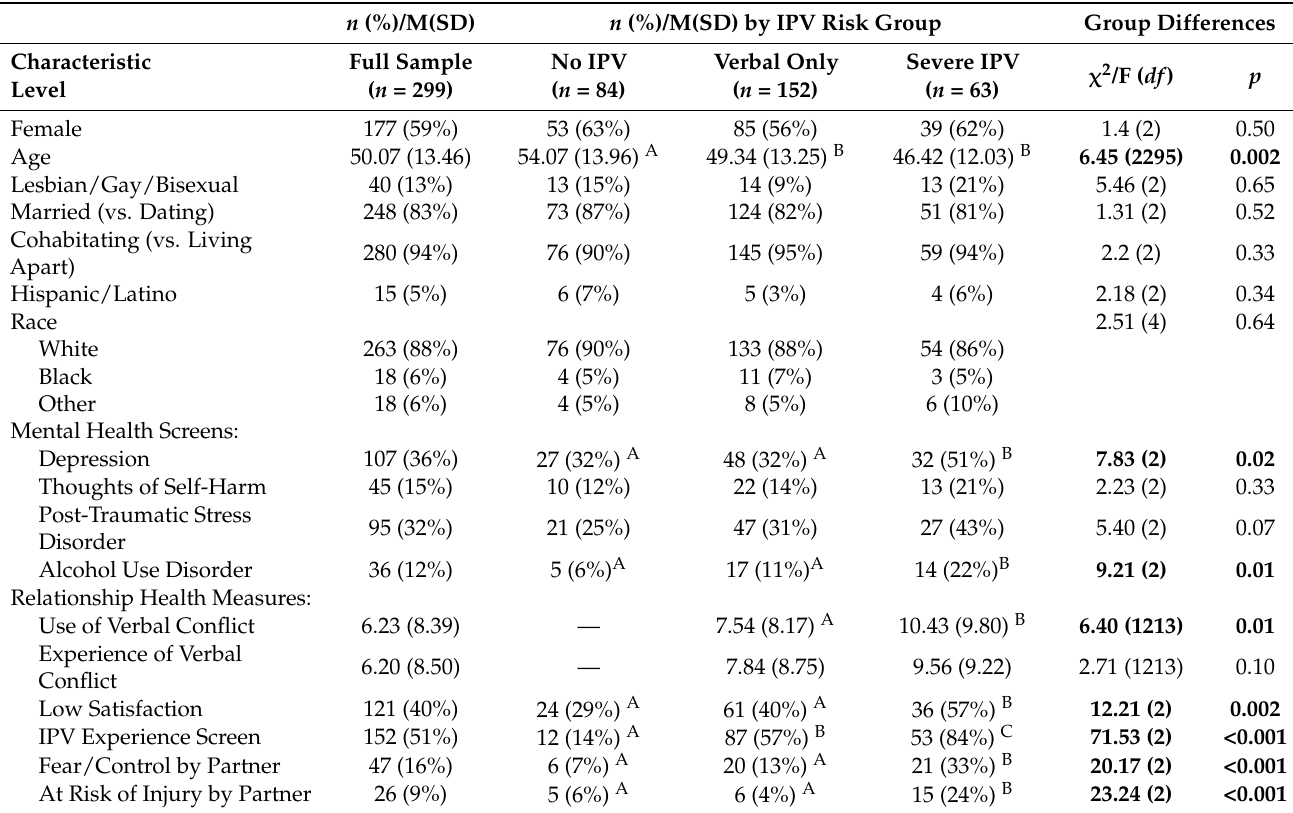
Table 2. Participant Characteristics by Intimate Partner Violence (IPV) Risk